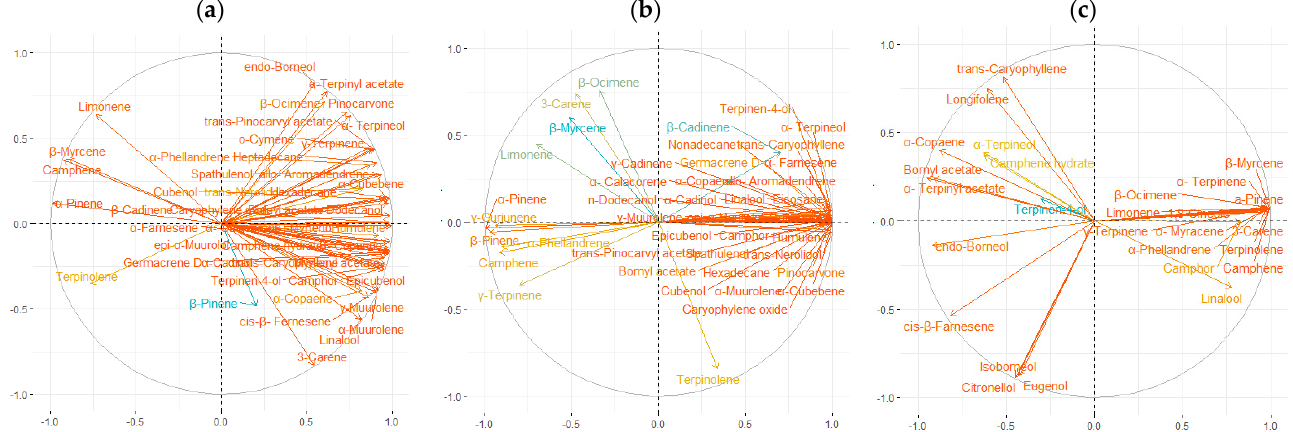
Figure 6. PCA loading plot performed on the BVOCs content in the genotypes of the examined species: ( a ) Austrian pine, ( b ) Scots pine, ( c ) Spruce.